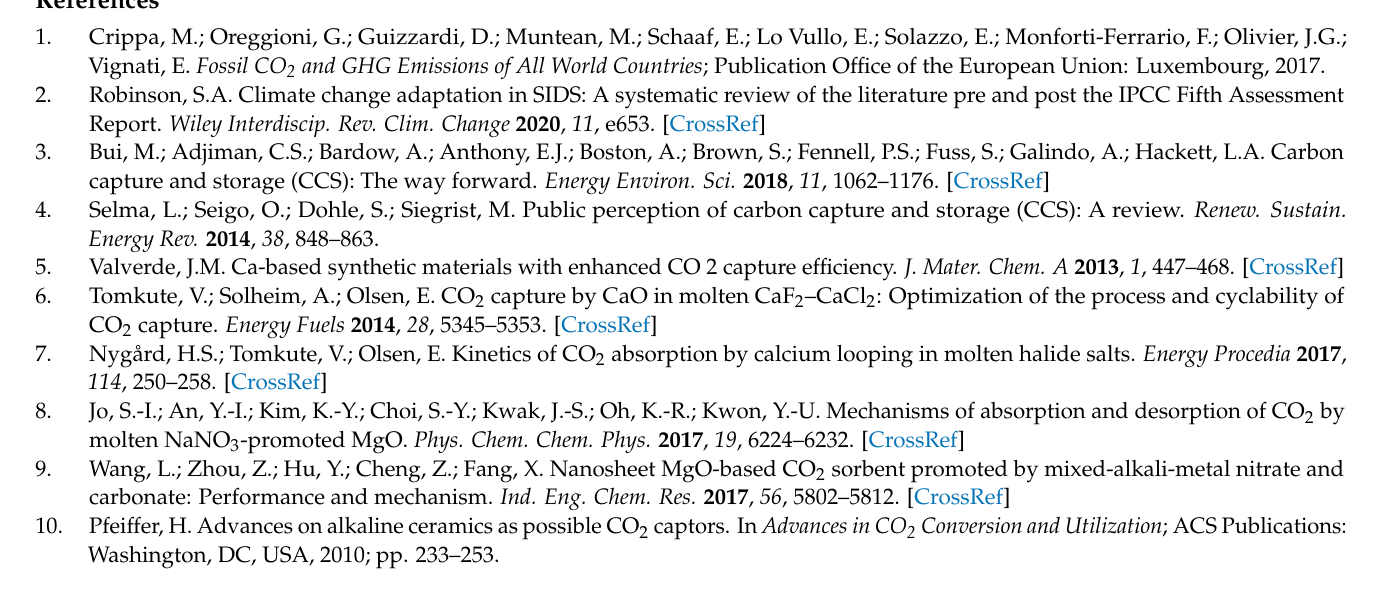
curves of Li 4 SiO 4 ; Figure S2: TG–DSC curves of 5(LiNa)95Na (a) and 5(LiNaK)95Na (b) at 50–900 ◦ C with a heating rate of 10 ◦ C · min − 1 in the 80%CO 2 –20%N 2 atmosphere; Dashed line: TG curves of P–Na.; Figure S3: TG–DSC curves of 10(LiNa)90Na (a) and 10(LiNaK)90Na (b) at 50–900 ◦ C with a heating rate of 10 ◦ C · min − 1 in the 80%CO 2 –20%N 2 atmosphere; Dashed line: TG curves of P–Na.; Figure S4: TG–DSC curves of 20(LiNa)80Na (a) and 20(LiNaK)80Na (b) at 50–900 ◦ C with a heating rate of 10 ◦ C · min − 1 in the 80%CO 2 –20%N 2 atmosphere; Dashed line: TG curves of P–Na.; Table S1. Weight gain and conversion of different samples at different